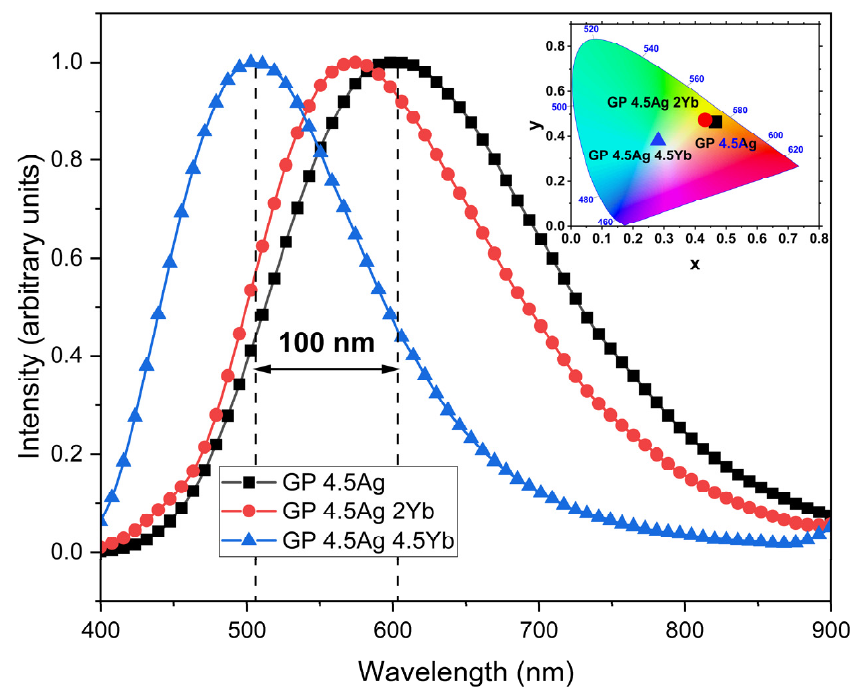
Figure 3 . Normalized PL of GP 4.5Ag, GP 4.5Ag2Yb, and GP 4.5Ag4.5Yb samples under excitation at 355 nm. The inset shows the samples chromaticity diagram (CIE-1931).